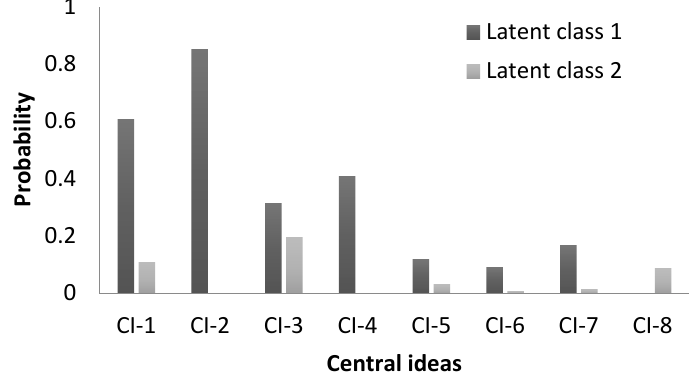
Figure 1. The probability of expressing each central idea (CI) for latent classes 1 and 2, including sheep farmers and citizens in the State of Rio Grande do Sul, Brazil, to consider each central idea as a definition of animal maltreatment: CI-1—Aggression or physical abuse, CI-2—Failure to provide basic needs as good nutrition, good environment or health, CI-3—Stress or suffering or fear or pain or painful procedures, CI-4—Space restriction or animal contained, CI-5—Deviation of naturalness or an isolated animal, CI-6—Emotional neglect, CI-7—Abandonment and CI-8—Non-classifiable.